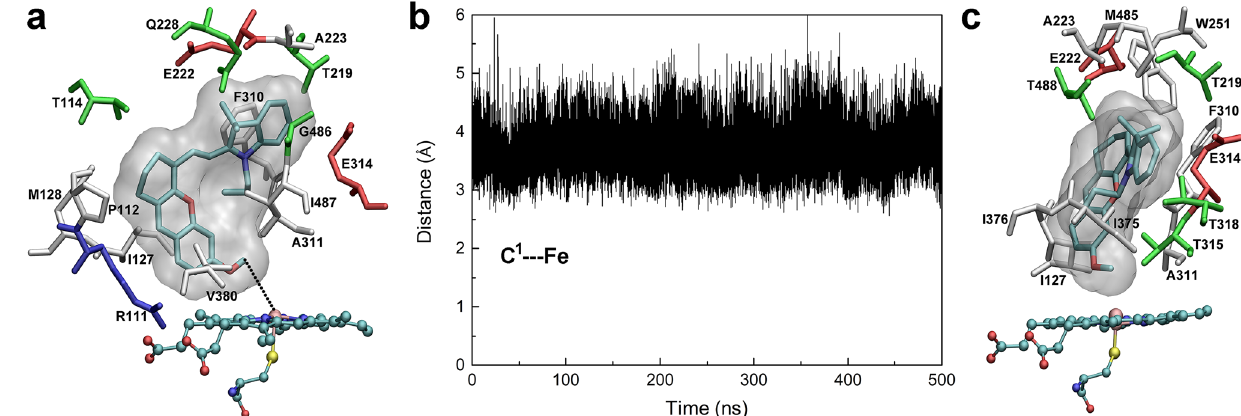
Figure 3. MD simulations of CYP2J2 in complex with M1 . ( a ) The initial binding pose of M1 in the active site of CYP2J2; ( b ) The distance between the proposed metabolic site (C 1 atom) and the heme iron during the simulations; and ( c ) The representative binding conformation of M1 in the active site of CYP2J2. Interacting residues with a contact frequency > 50% calculated from the last 100-ns trajectory were shown and colored based on their types: blue for basic, red for acidic, green for polar, and white for nonpolar residues. A contact occurs if any atom of the ligand is within 3 of any atom of protein residues. This figure was rendered using VMD 27 (http://www.ks.uiuc.edu/Resea rch/vmd/). Å